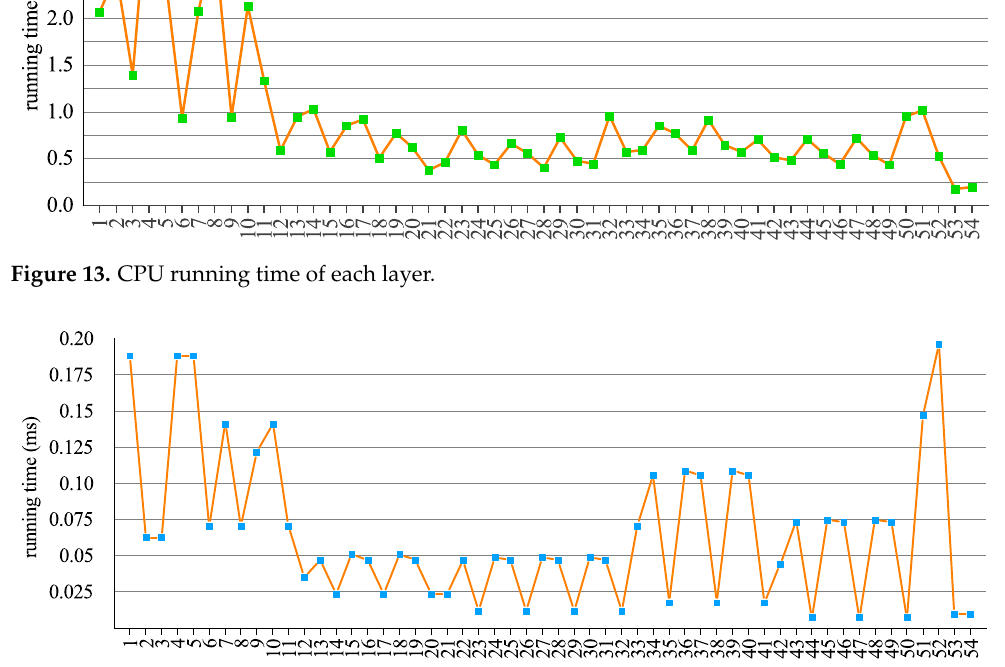
Figure 14. Accelerator running time of each